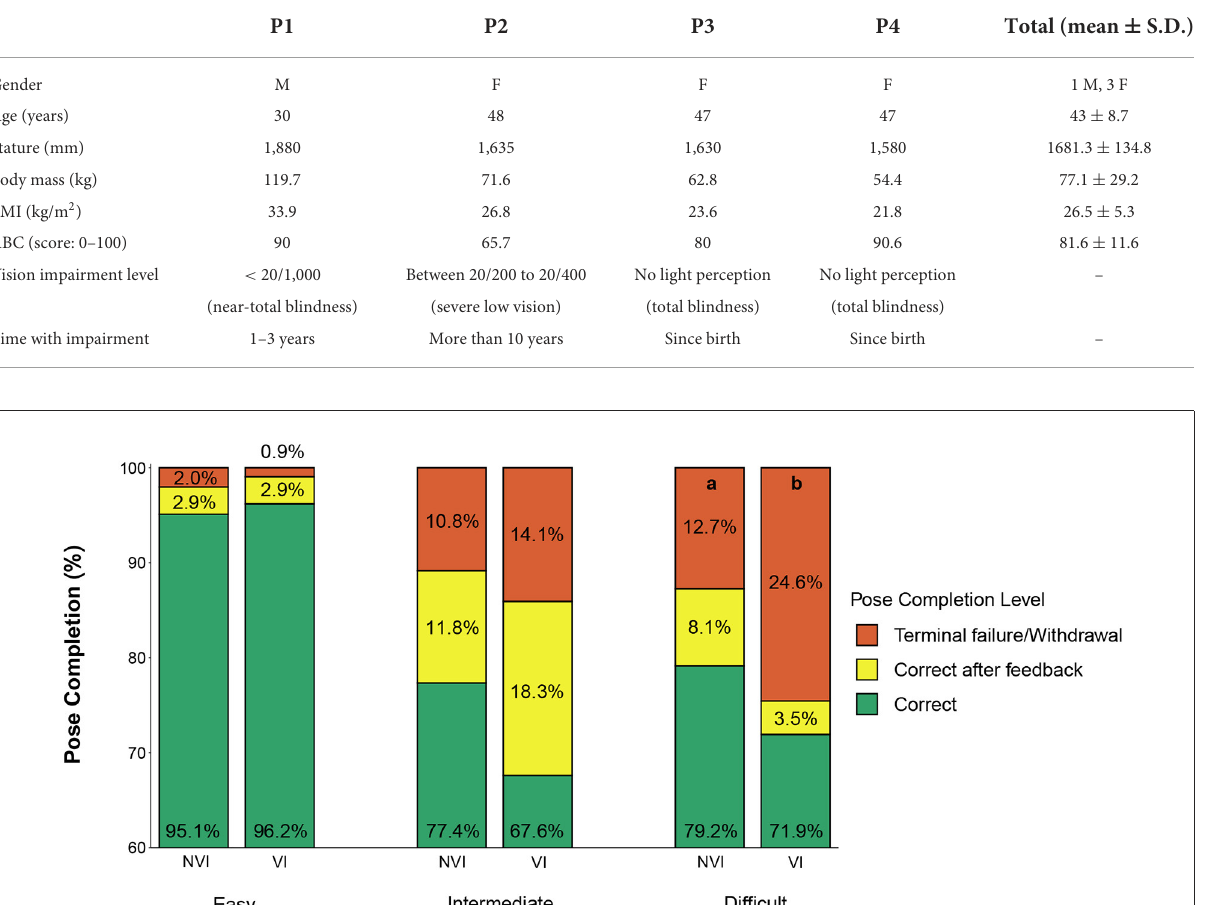
TABLE 2 Summary demographics of VI participants ( n = 4).